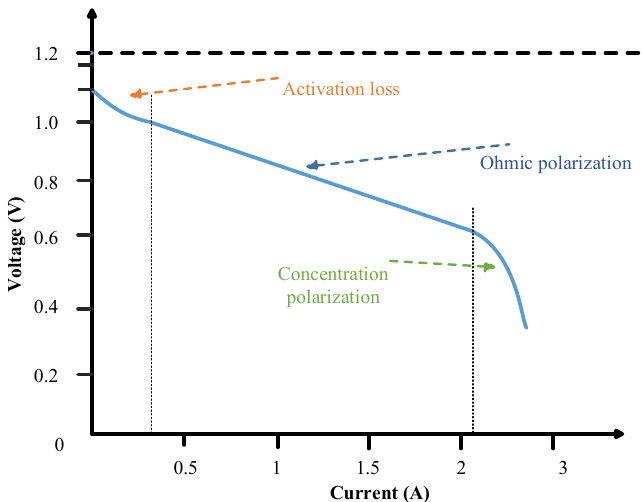
Figure 3. Polarization curve of SOFC.